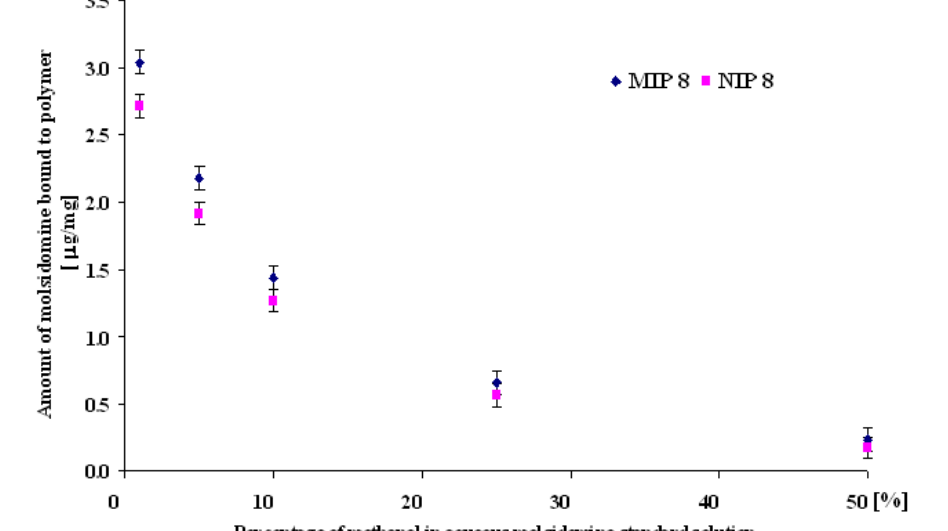
Figure 8 . Amount of molsidomine bound to MIP8 and NIP8 in methanol-water